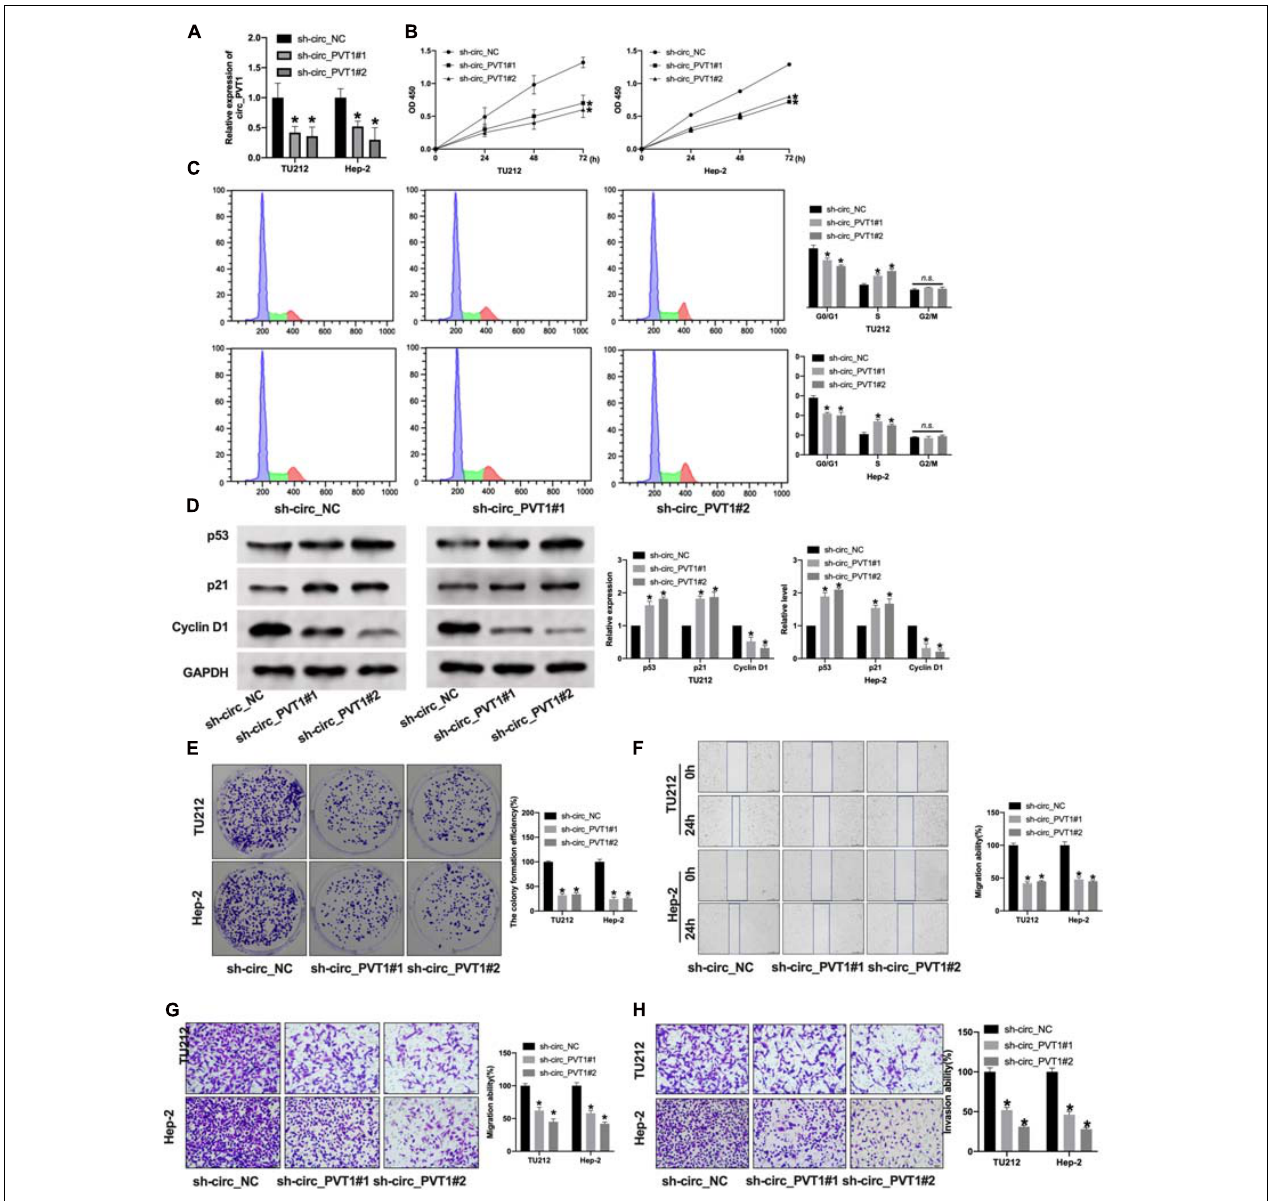
FIGURE 2 | Silencing of circ_PVT1 inhibits proliferation, migration, and invasion in LC cells. (A) The knockdown efficiency of shRNA circ_PVT1 (sh-circ_PVT1#1, sh-circ_PVT1#2) was detected by qRT-PCR. * P < 0.05, n = 5. (B) CCK-8 assay was used to detect the cell viability in TU212 and Hep-2 cells. * P < 0.05, n = 5. (C) Flow cytometry was performed to assess the cell cycle in TU212 and Hep-2 cells. * P < 0.05, n = 5 ( n.s. as no significant). (D) The protein level of p53, p21, and Cyclin D1 in TU212 and Hep-2 cells after sh-circ_PVT1 knockdown. * P < 0.05, n = 5. (E) The clone formation of LC cells after sh-circ_PVT1#1 and sh-circ_PVT1#2 knockdown. * P < 0.05, n = 5. (F) Wound healing assay was performed to assess the migration ability. * P < 0.05, n = 4. (G) Transwell migration assay was used to determine the migration ability. * P < 0.05, n = 4. (H) Transwell invasion assay was used to determine the invasion ability. * P < 0.05, n = 4.